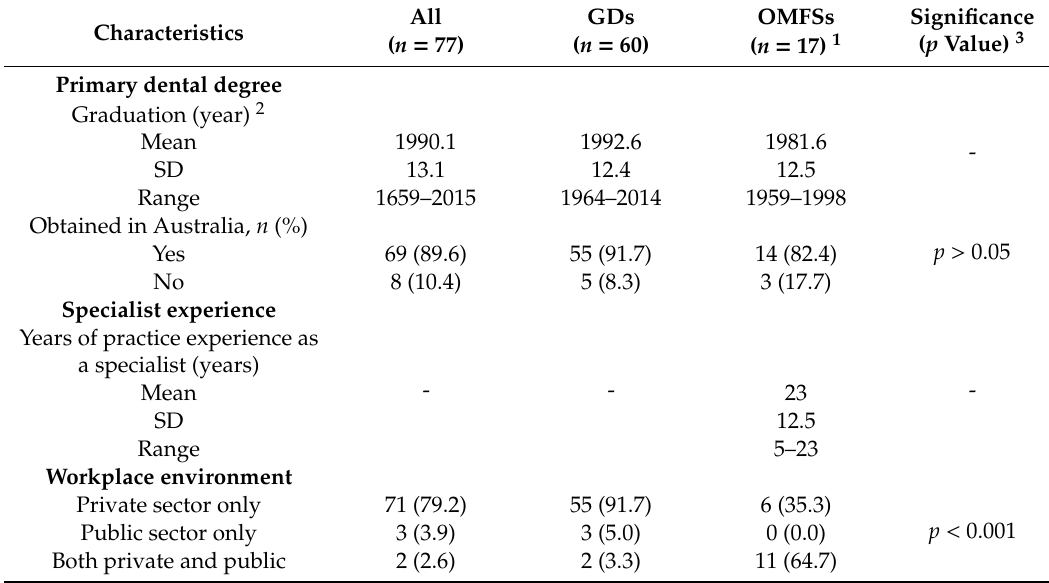
Table 1. Participant